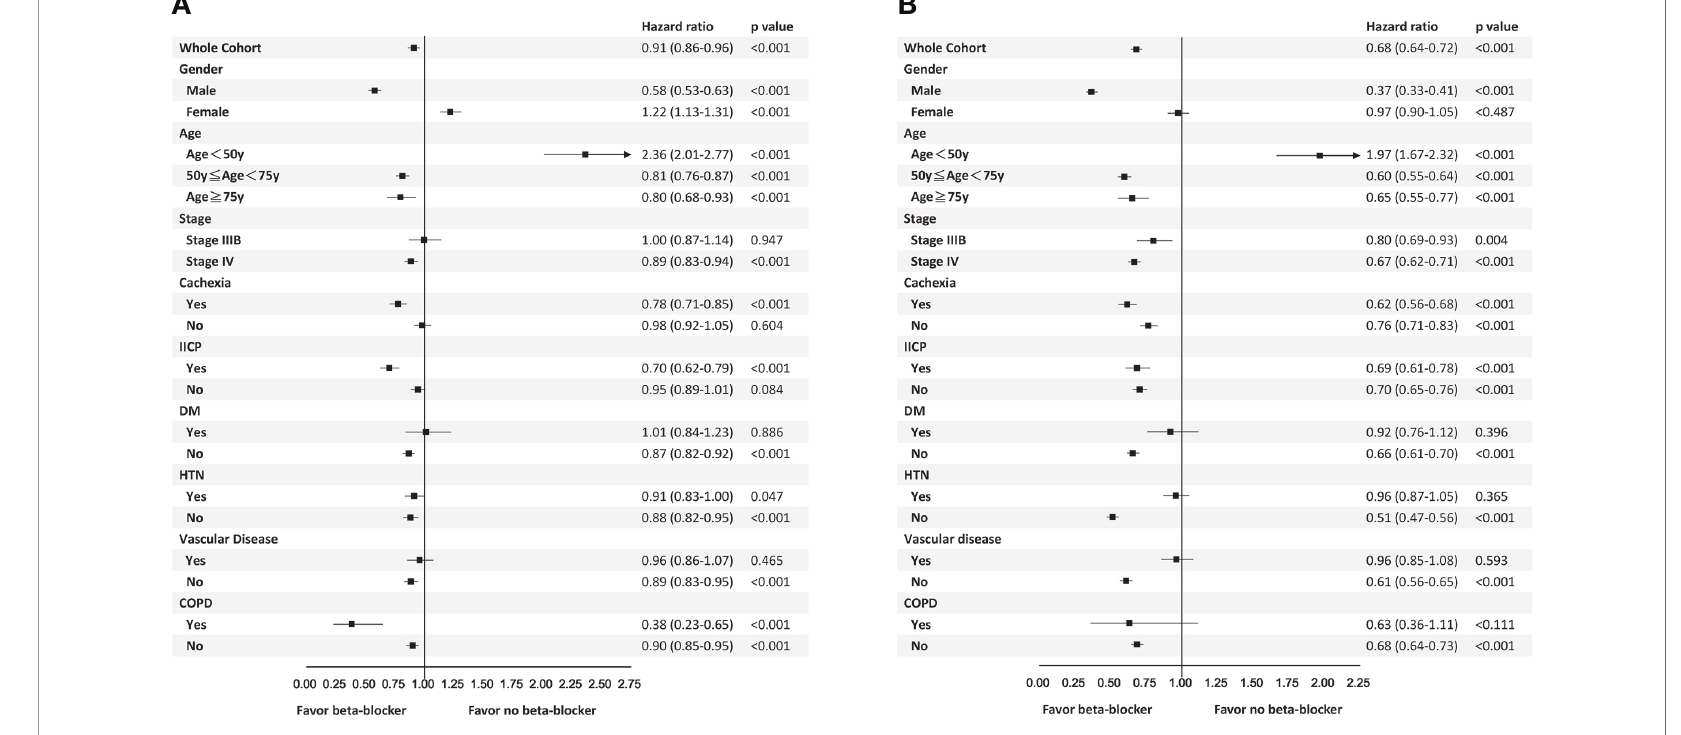
FIGURE 3 | Subgroup analyses for time to discontinuation of epidermal growth factor receptor-tyrosine kinase inhibitors within 2 years (A) and 4-year overall survival (B)